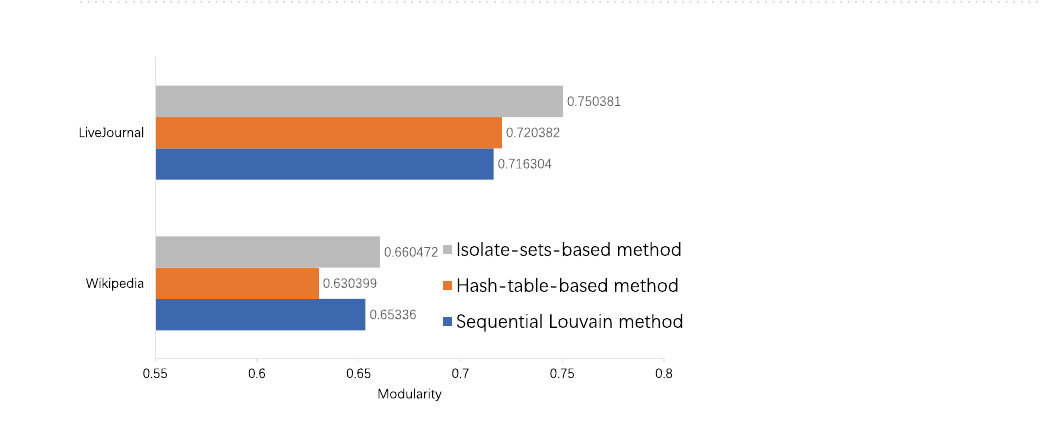
Figure 5. Modularity comparison.